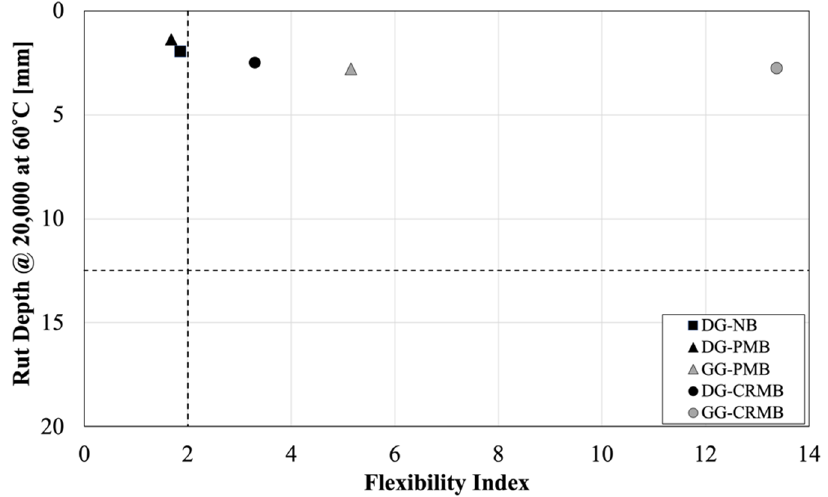
Figure 7. Performance-Space Diagram.